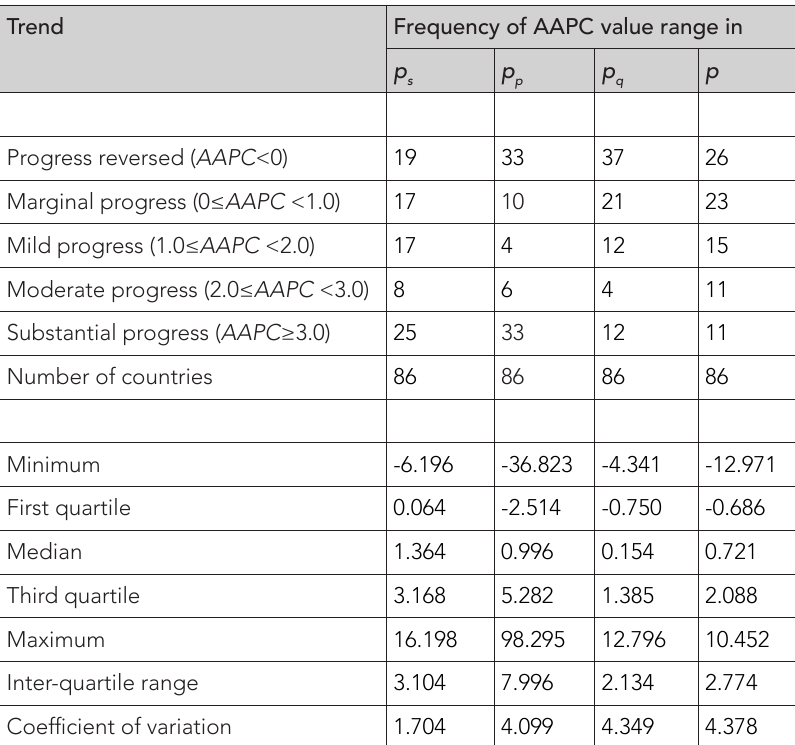
Table 3: Average Annual Per Cent Change ( AAPC ) in Different Indexes of Family Planning Progress in 86 Countries During